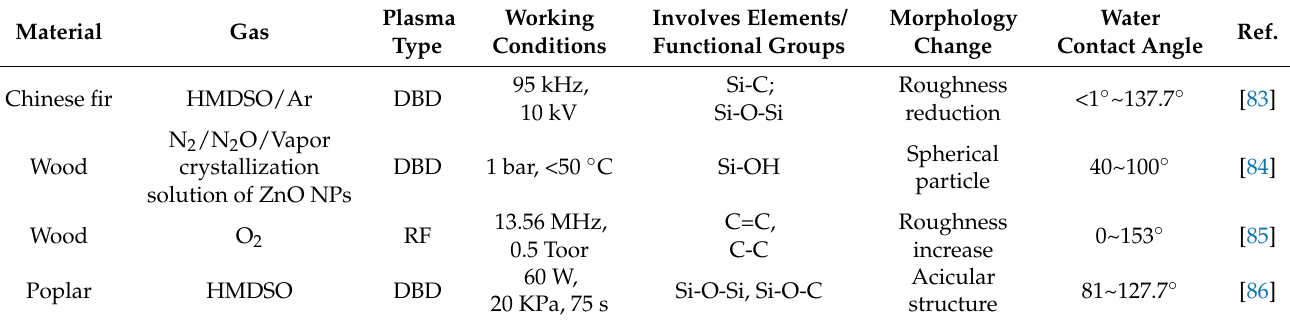
Table 4. Plasma treatment of wood